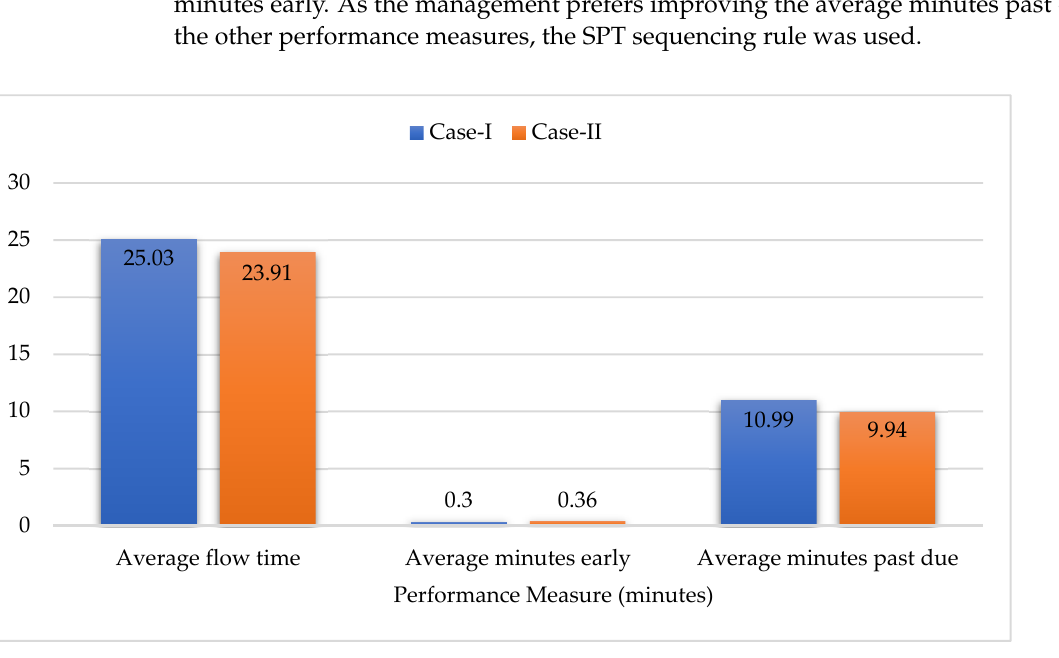
19 of 22 Figure 6. Comparison of the processing times for Case-I and Case-II using the FCFS rule. The performance measures considered for the abovementioned priority sequencing